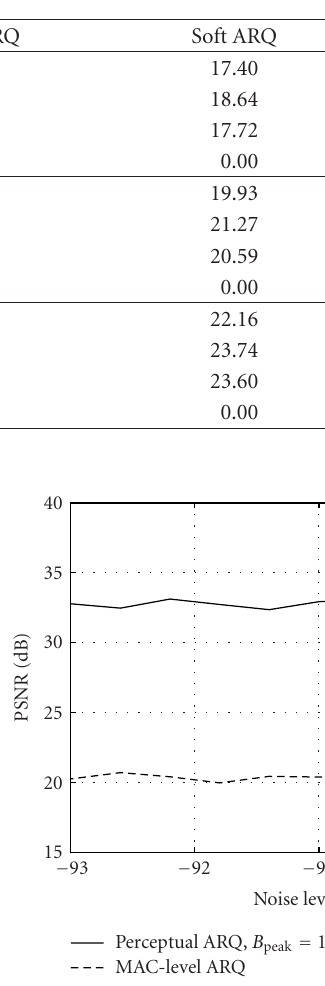
Table 4: Packet loss rate (%) of concurrent tra ffi c for di ff erent retransmission schemes. B peak is equal to 130% for the application-level ARQ schemes. The table shows the highest observed value.